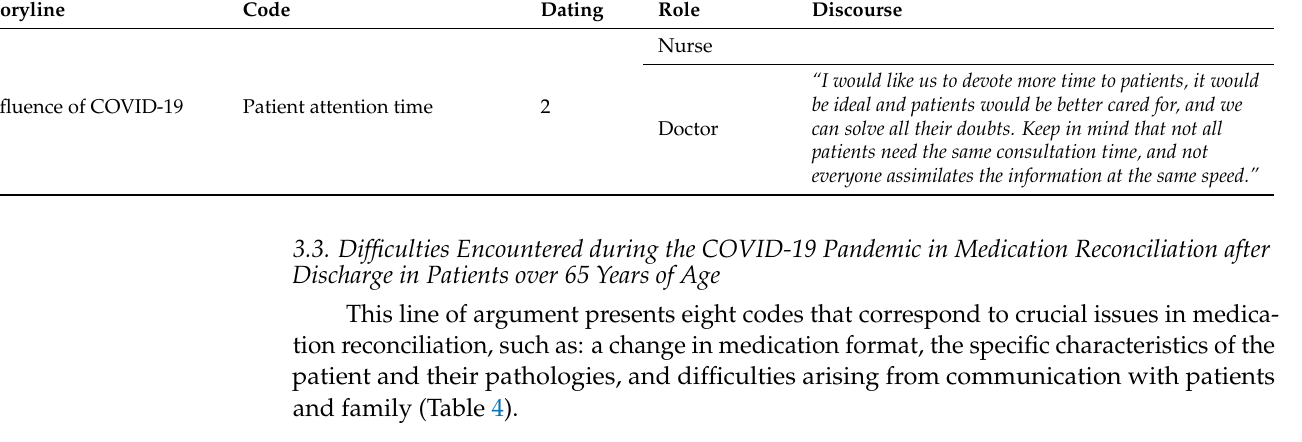
Table 4. Description of the difficulties involved in medication reconciliation. Codes and discourse of nurses and primary care